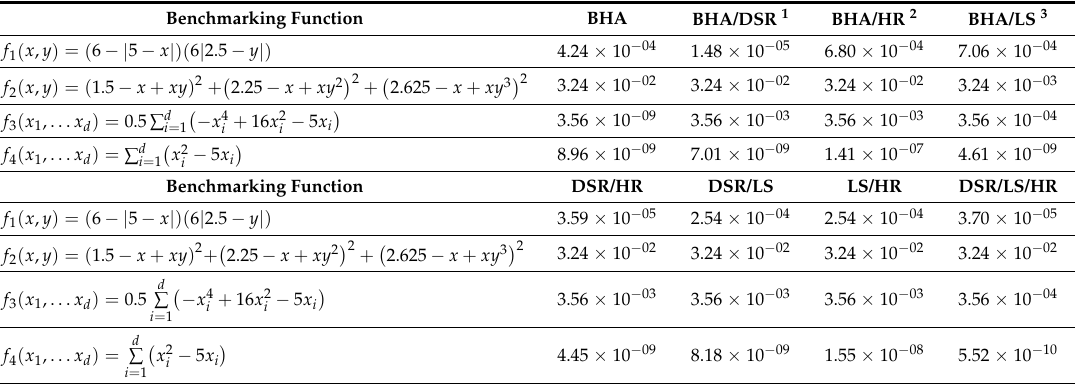
Table 2. Performance evaluation of different BHA solutions with benchmarking functions. Benchmarking Function